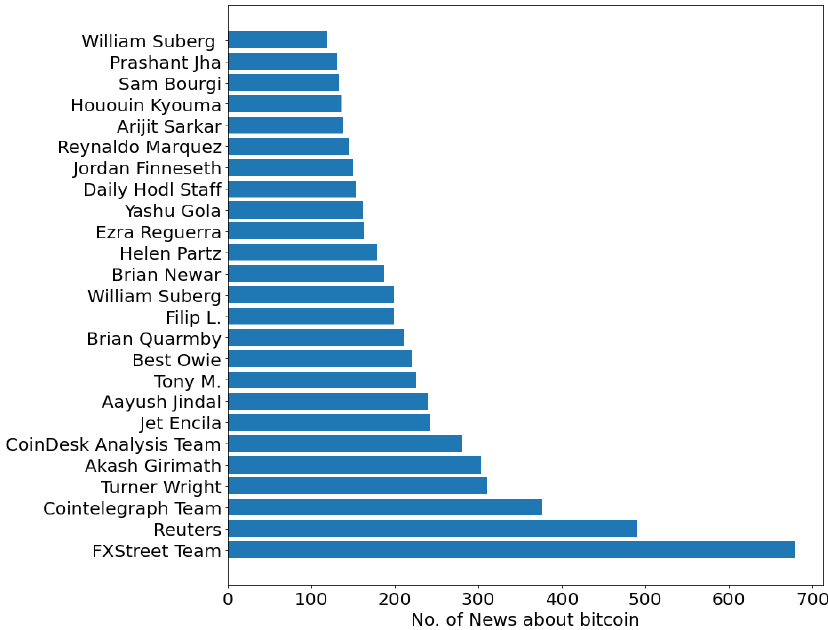
Figure 4. Number of news related to Bitcoin in MarketNews dataset in terms of